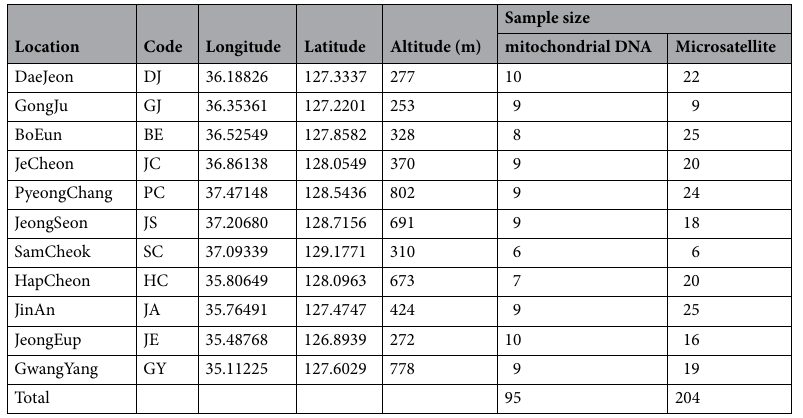
Table 1. Information of Karsenia koreana populations and samples analyzed in this